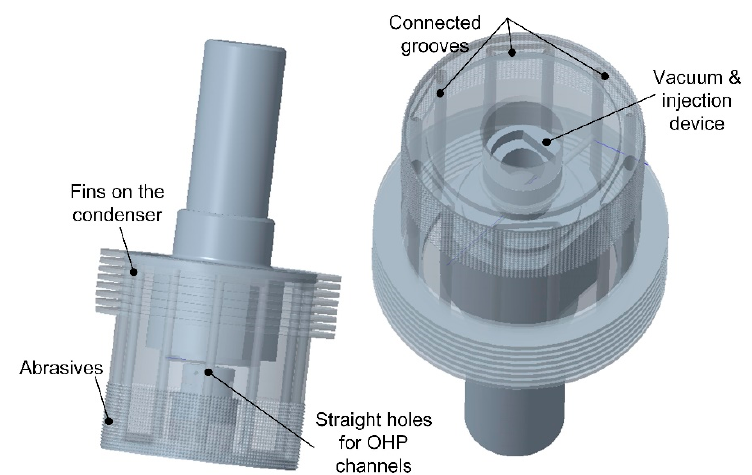
Figure 1. The design of the oscillating heat pipe (OHP) grinding wheel (the matrix is set as transparent for a better illustration).